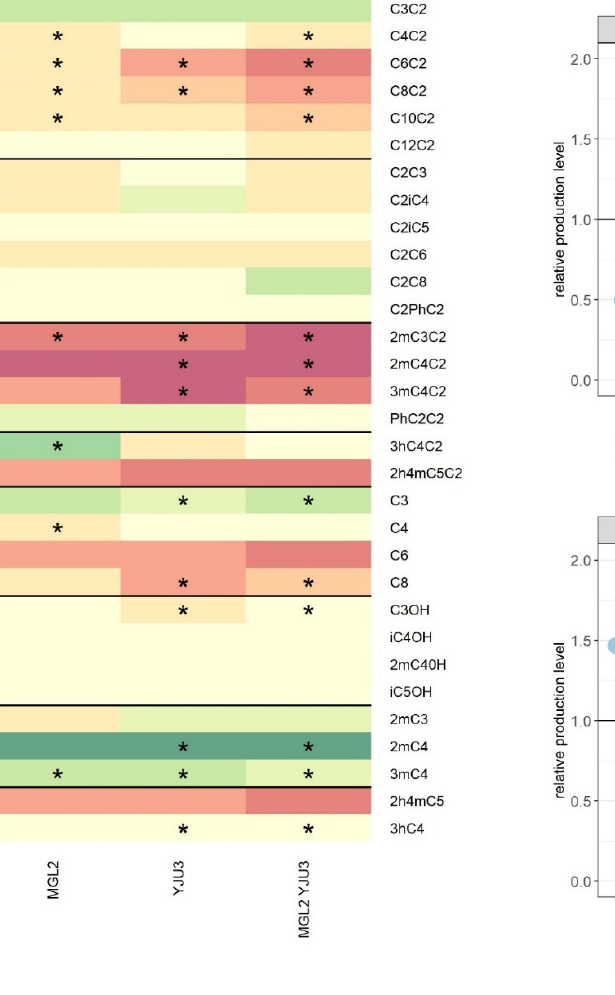
Figure 4. Effect of mono-acyl glycerol lipases (Mgl2p/Yju3p) inactivation on substituted esters and their relative metabolic precursors. The raw values of each deletion strain ( MGL2 and/or YJU3 ) were normalized by the average value of the control strain Fx10. ( a ) Modalities significantly different from the wt are shown for all the volatile compounds measured. ( b ) Deletion effect for significantly impacted AEE. ( c ) Deletion effect for HEE and their relative metabolic precursors. Each point and bar represents the mean and the standard error computed from 4 independent biological repetitions measured in two grape juices. The symbols * indicate which modality is significantly different from the wt according to a post hoc HSD test ( α = 0.001).